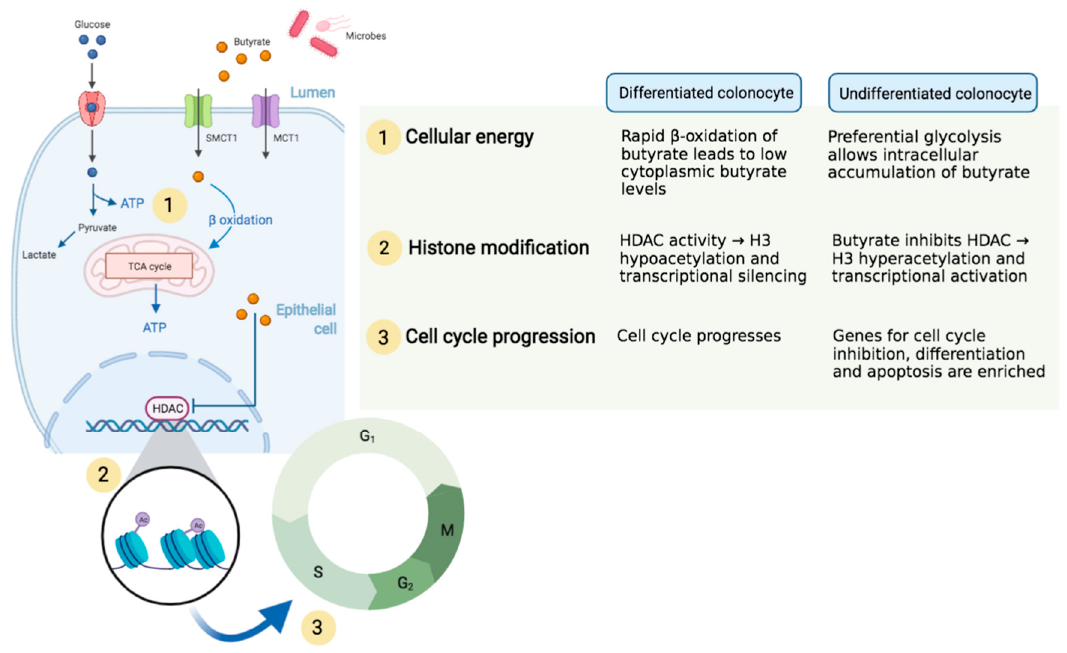
Figure 1. Distinct metabolic pathways for cellular energy in differentiated and undifferentiated colonocytes are responsible for ‘the butyrate paradox’. Microbially-derived butyrate in the colonic lumen is transported intracellularly by SMCT1 and MCT1, among other membrane-bound transport proteins. The fate of cytoplasmic butyrate depends on the cell’s state of differentiation. (1) In differentiated colonocytes, butyrate is rapidly oxidized and utilized for cellular energy production. In undifferentiated colonocytes, such as neoplastic cells, cellular fuel is preferentially derived from glycolytic pathways, leading to intracellular butyrate accumulation. (2) Butyrate is an HDAC inhibitor, which results in hyperacetylation of histone H3 with consequent chromatin relaxation and expression of genes otherwise silenced by HDAC activity. (3) Specifically, butyrate-induced histone modification is associated with transcriptional activation of genes involved in cell cycle inhibition and apoptosis.